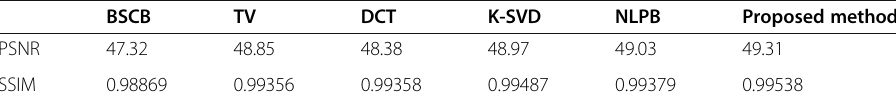
Table 7 Average PSNR and SSIM of each method